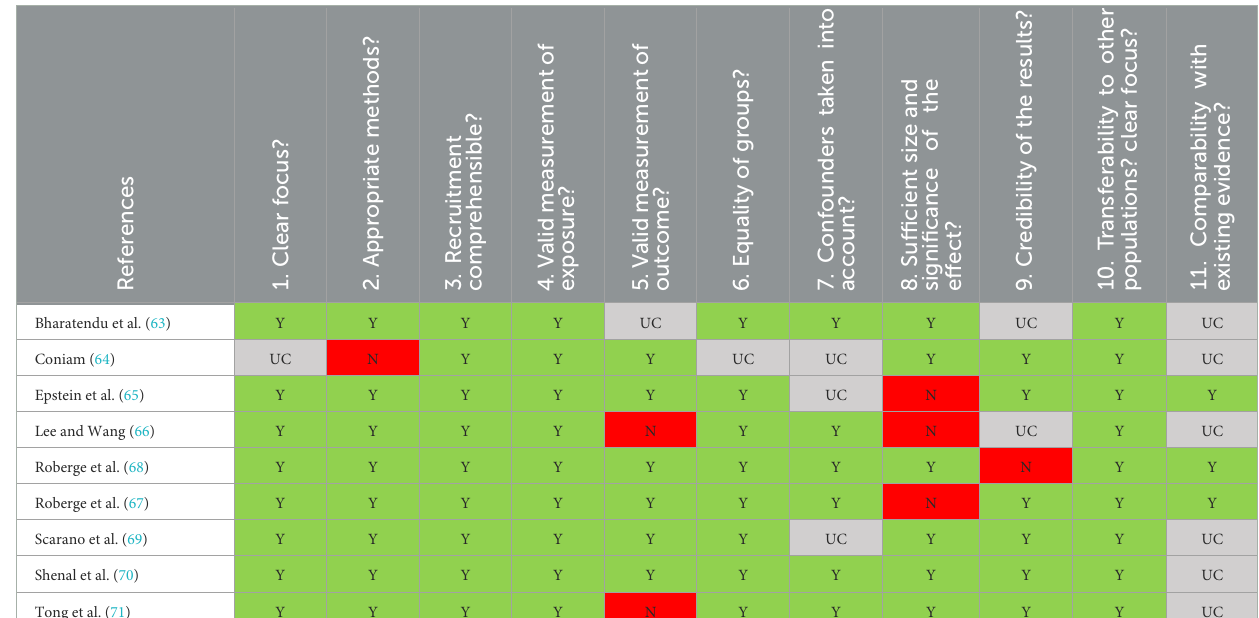
TABLE 2B Quality appraisal of non-randomized controlled trials (CASP